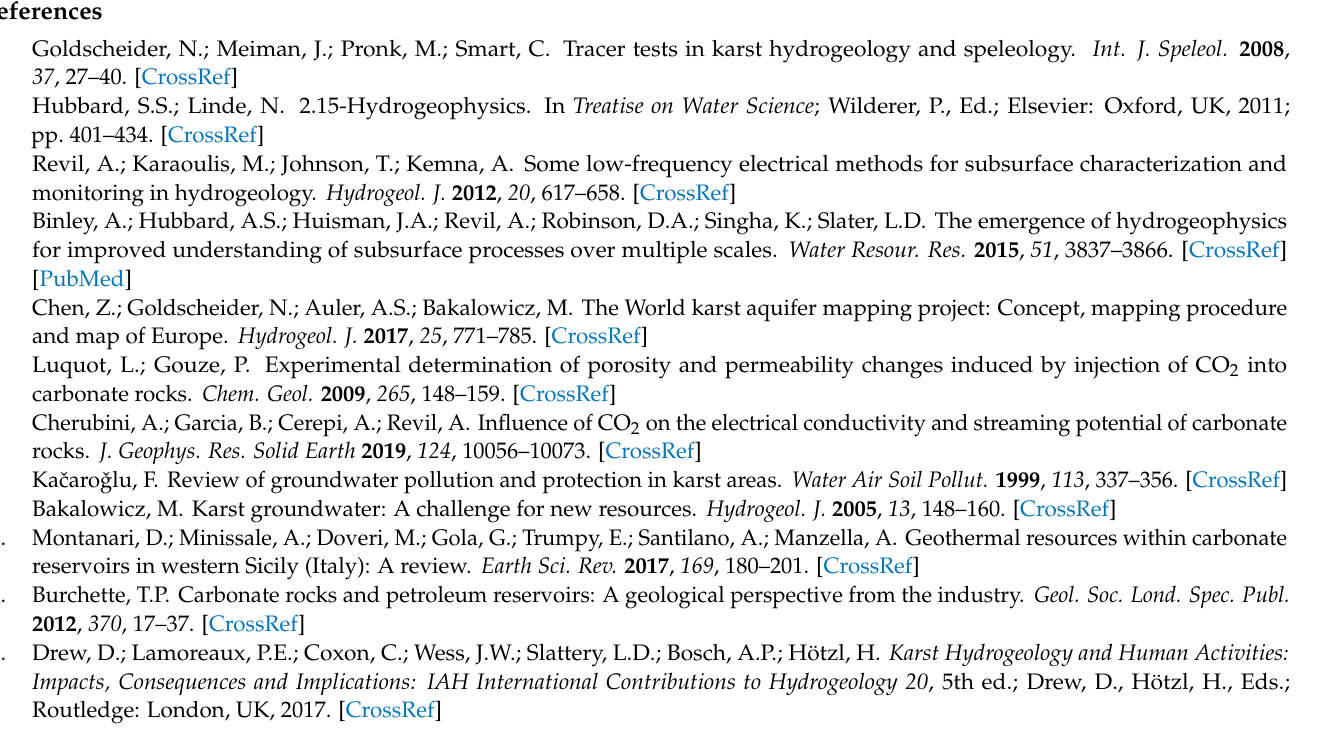
Figure A2. ( a , b ) Sample EC computed from Equations (11) and (13). ( c , d ) Electro-diffusive voltage modeled from the computation of the sample